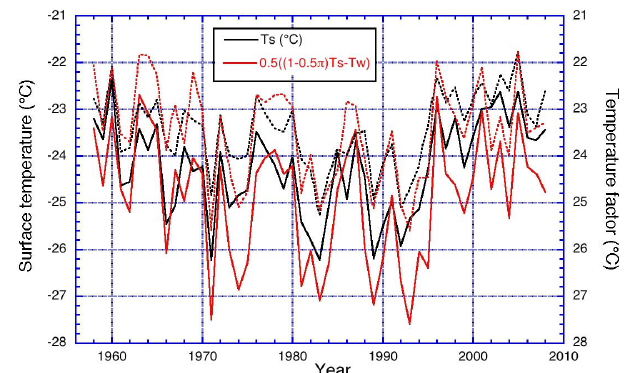
Fig. 5. Time series of ice sheet averaged annual averaged surface temperature ( T s , black) and temperature factor used in Eq. (7) (red) based on RACMO2 (solid lines) and MAR (dashed lines) fields. Note the reversed axis on the right hand side.